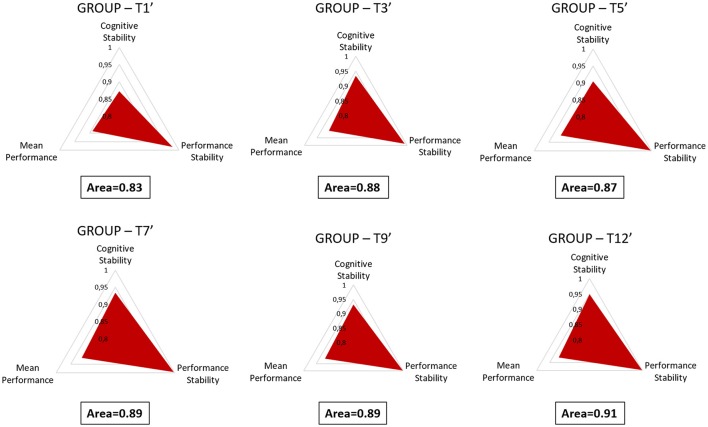
In order to quantify the users' training level along the training sessions, the behavioral and neurophysiological measures were integrated. Such measures were used to define the sides of a scalene triangle, and then the Area of such a triangle was calculated in each training session as measure of the training level. The Area was normalized with respect to its maximum with the aim to have as references of maximum training the value “1.”